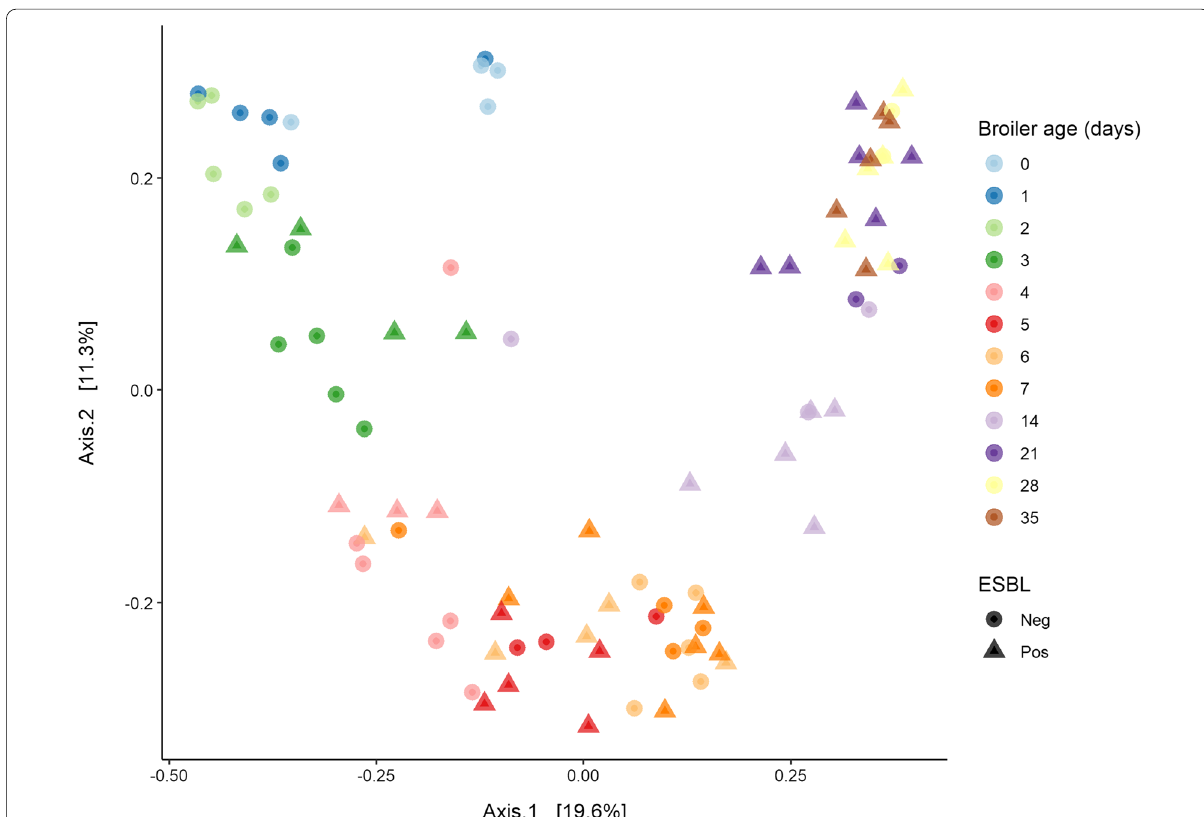
Fig. 5 Principal coordinate analysis based on Bray Curtis dissimilarity metrics (BC‑PCoA). Changes in the caecal microbial community composition over time (day 0–35). Age explained 14% of the compositional variation of the caecal microbiome (BC‑dbRDA: F